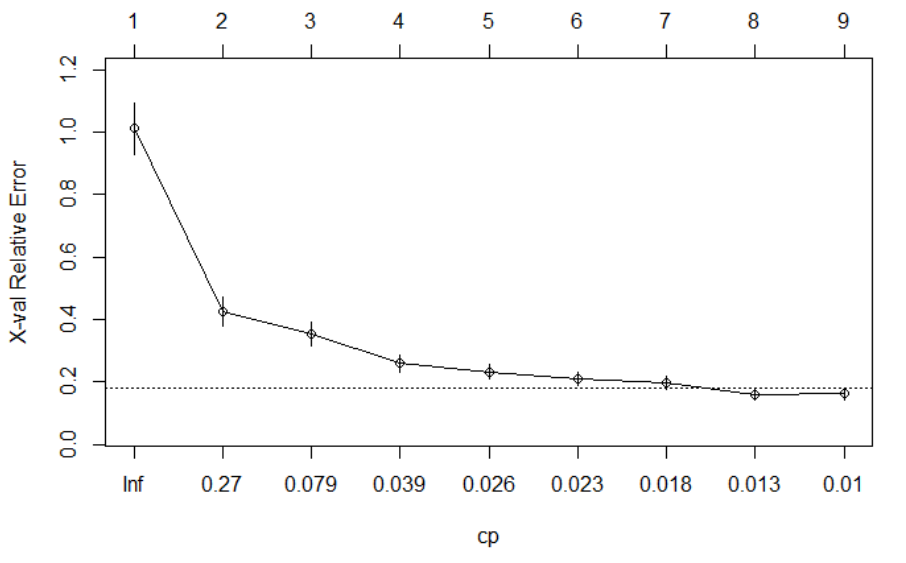
Figure 4. Cross-validation error versus cost complexity factor.